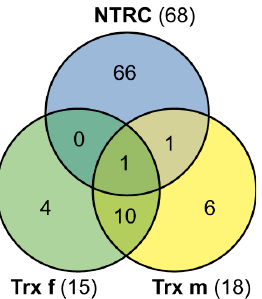
Figure 4. Comparison of Trx specificity. Venn diagram representation showing the overlap between candidate target proteins for Trx f, Trx m and NTRC.